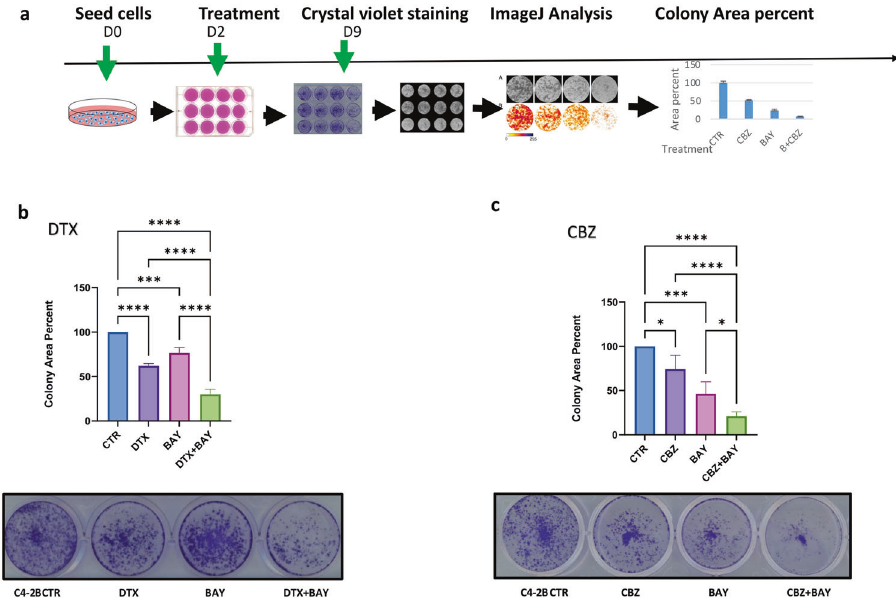
Fig. 1 Mps1i BAY potentiates ef fi cacy of Taxanes treatment. a Schematics of experiments. b , c 10 5 C4-2B CRPC cells were plated in 12-well plate and treated 2 days later with b Docetaxel (DTX 0.1 nM, Mps1i BAY 0.25 nM), c Cabazitaxel (CBZ 0.05 nM, Mps1i BAY 2 nM) or combination for 24 h in triplicates. Colonies were stained with crystal violet 7 days later. ImageJ was used to calculate the area of the colonies (top); representative images (bottom). Experiments were repeated at least three times in triplicates; representative results are shown. In b